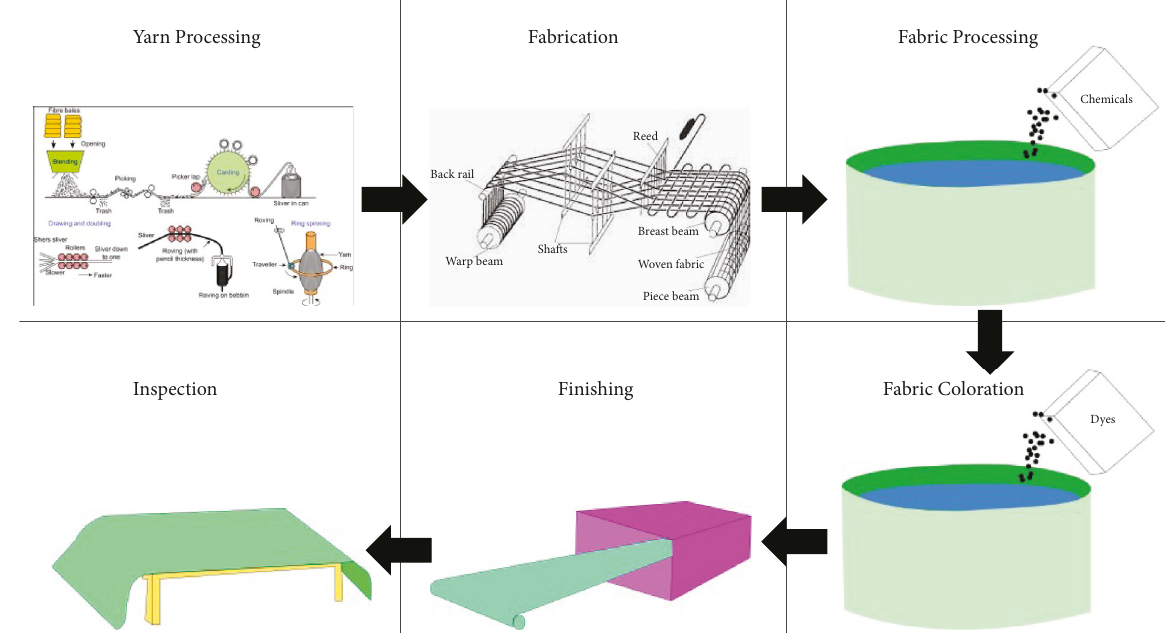
Figure 1: Flowchart of production of textile